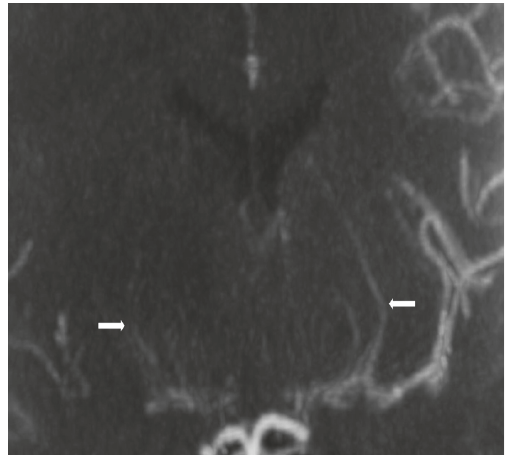
Figure 4: Coronal MIP demonstrates prominent lenticulostriate collaterals in the basal ganglia